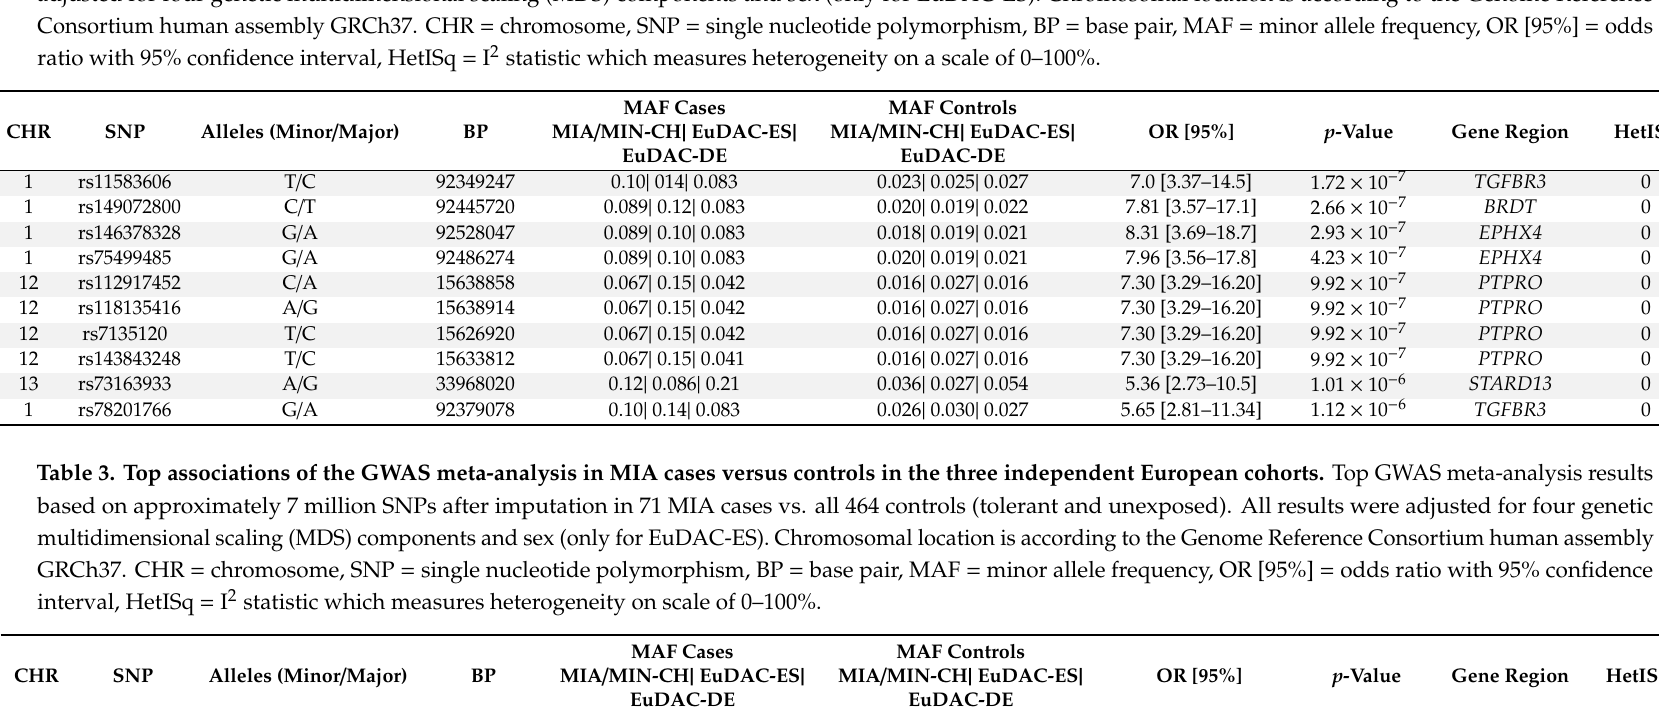
Table 2. Top associations of the GWAS meta-analysis with MIA / MIN in all cases versus controls in the three independent European cohorts. Top GWAS meta-analysis results based on approximately 7 million SNPs after imputation in 83 MIA / MIN cases vs. all 464 controls (tolerant and unexposed). All results were adjusted for four genetic multidimensional scaling (MDS) components and sex (only for EuDAC-ES). Chromosomal location is according to the Genome Reference